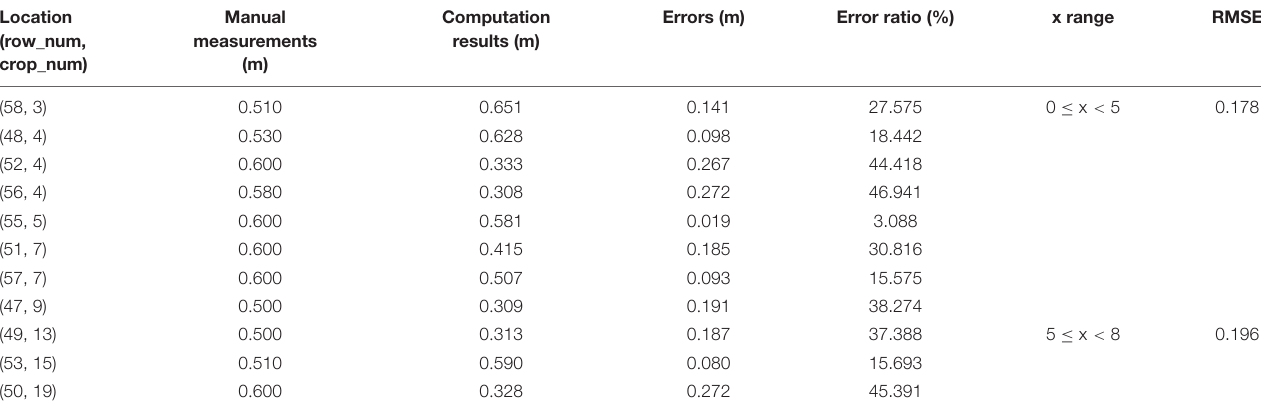
TABLE 5 | Plant height computation results for sub-area A1.